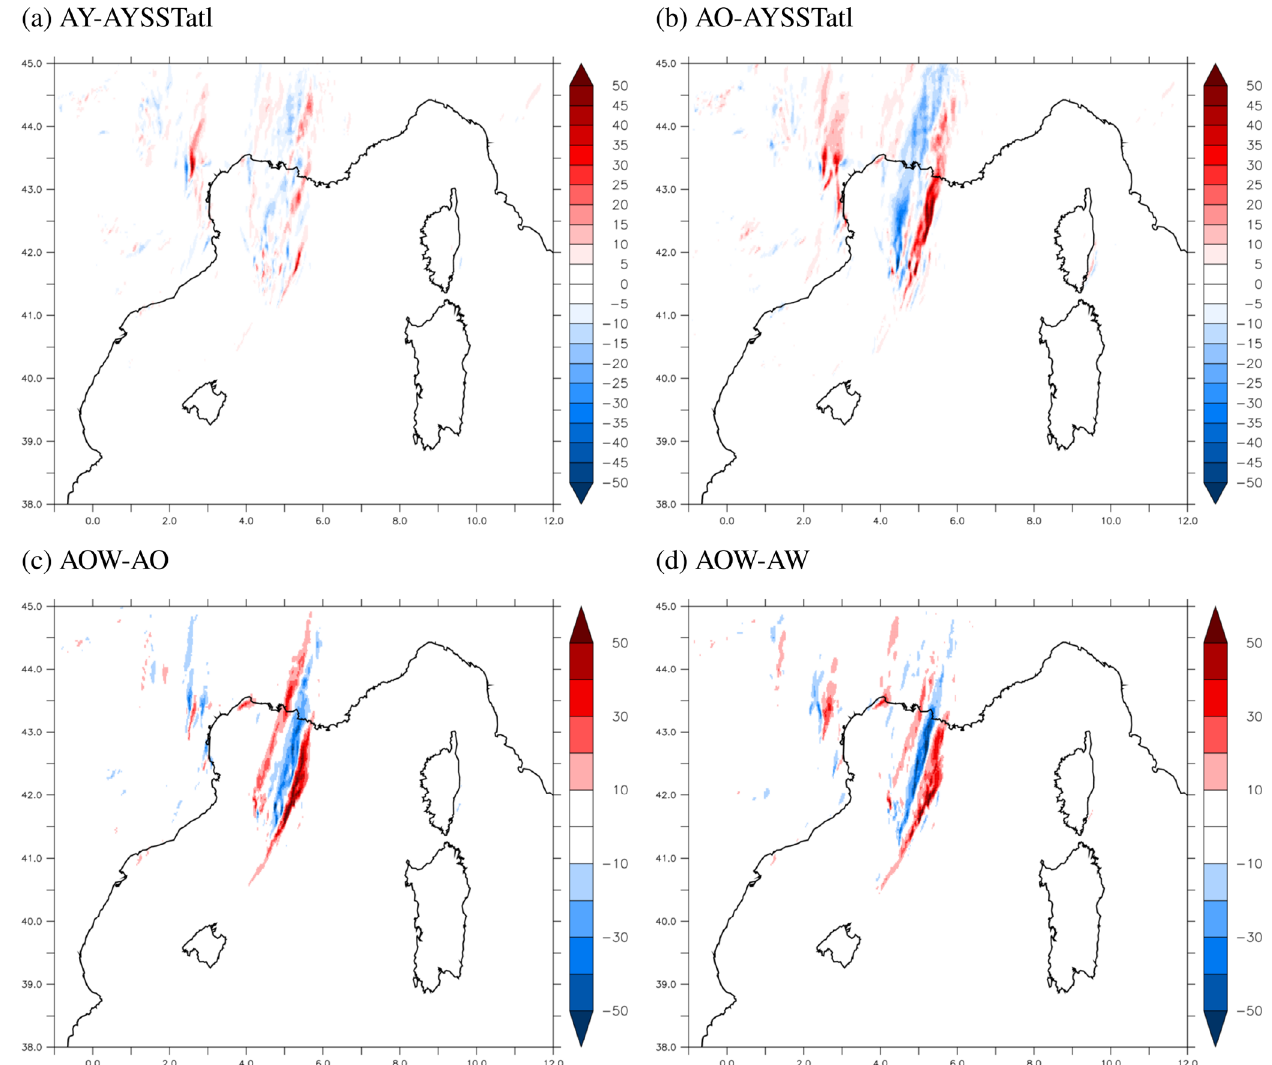
Figure 8. Differences in 6h cumulative precipitation ( mm ) at 00:00UTC on 14 October (a) between AOW and AO and (b) between AOW and